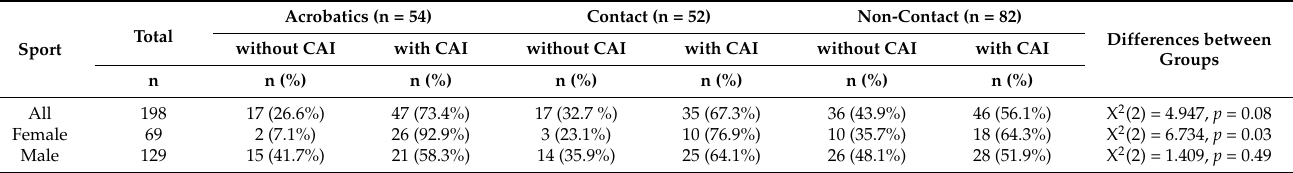
Table 4. Prevalence of chronic ankle instability (CAI) for each category of